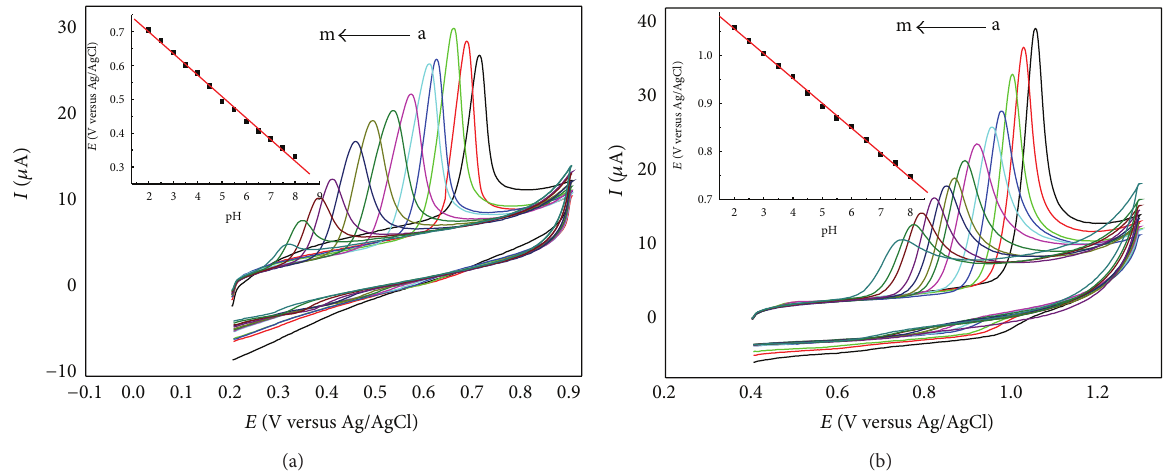
Figure 6: CVs of UA (a) and Xa (b) with different pH. Insets show the calibration plots of E-pH . From a to m: pH = 2.0, 2.5, 3.0, 3.5, 4.0, 4.5, 5.0, 5.5, 6.0, 6.5, 7.0, 7.5, 8.0.